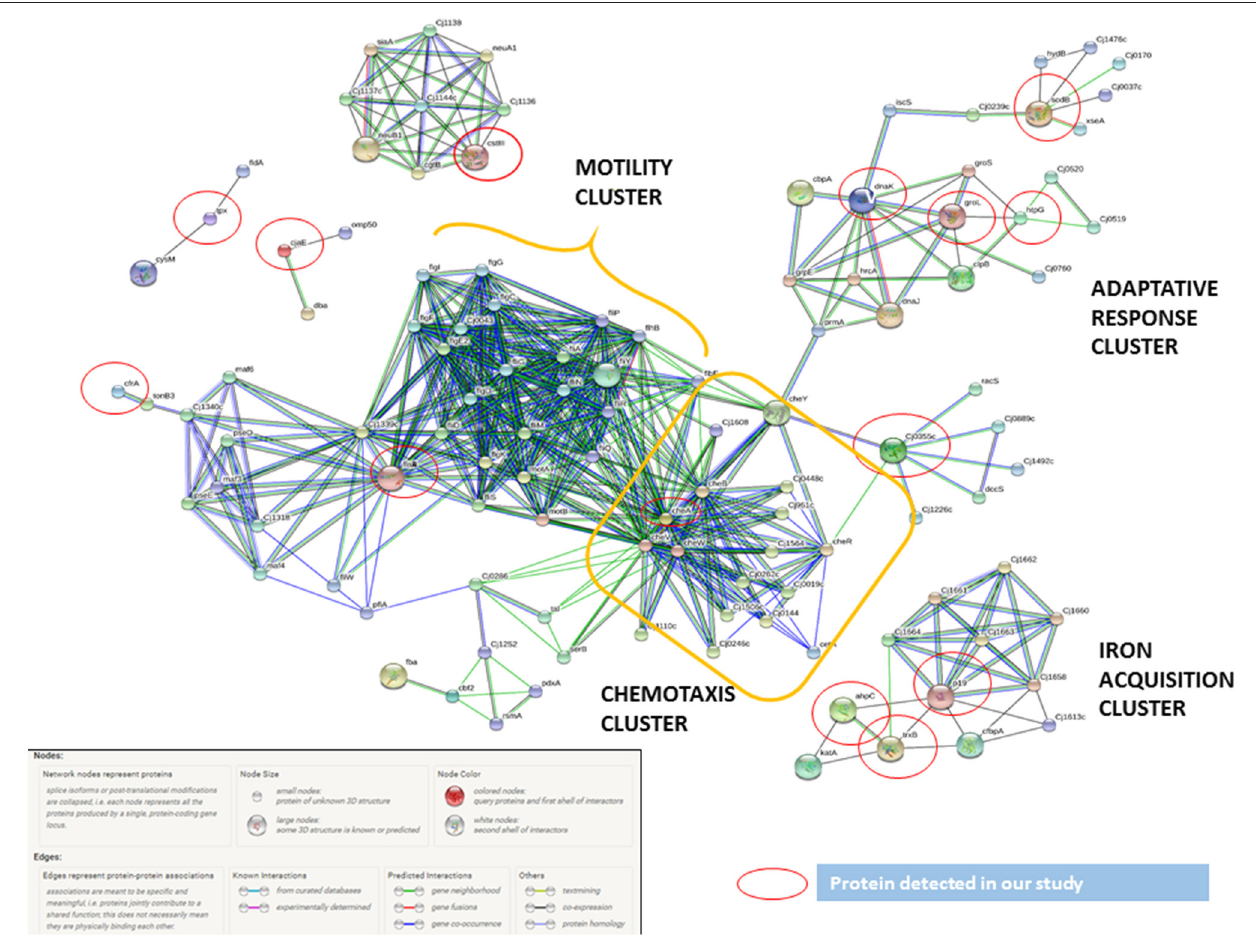
FIGURE 3 | C. jejuni virulence proteins interaction network. The network allocated the C. jejuni detected proteins in INT-407 cell line (red circles) together with functional partners. The biggest cluster was associated to chemotaxis and related to cluster including all motility proteins. The other proteins included were associated to adaptive response (heat shock and oxidative stress proteins) and iron acquisition